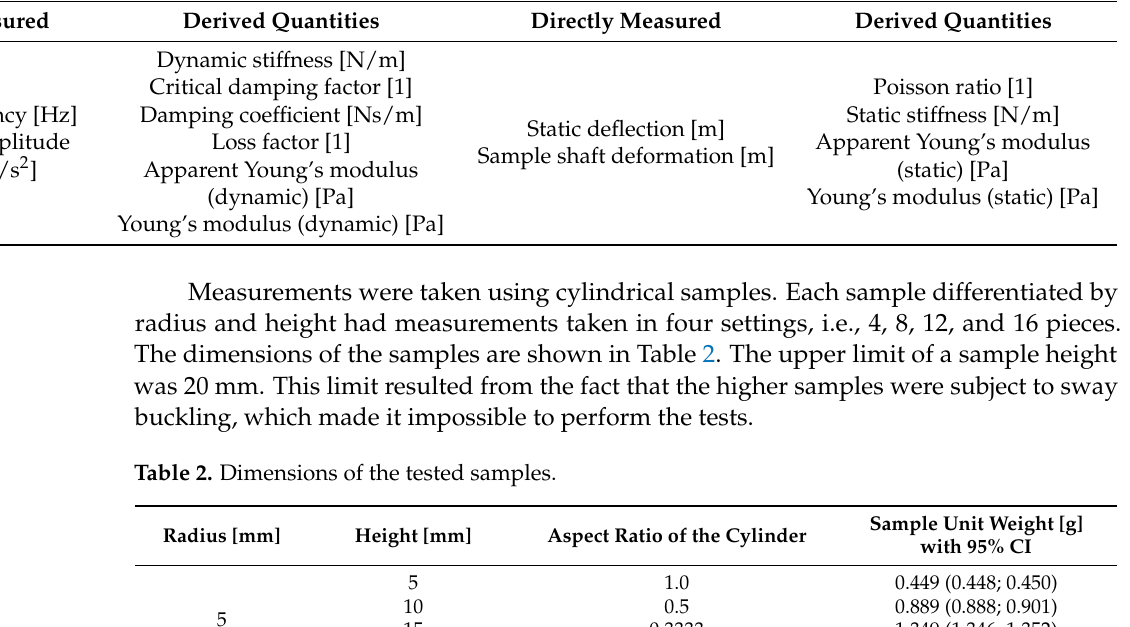
Table 1. Measured parameters as part of methods using response spectrum and image processing.